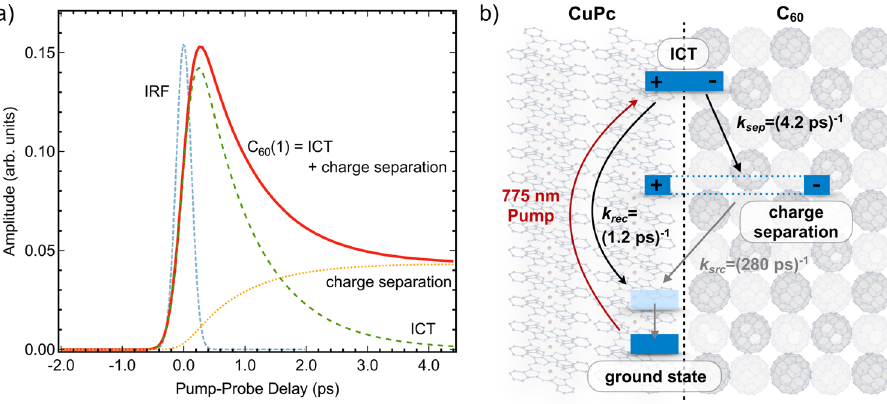
Fig. 5 Dynamic evolution of the C 60 (1) signal amplitude and kinetic modeling. a Temporal evolution and b kinetic modeling of the C 60 (1) peak intensity. The C 60 (1) peak intensity represents the fraction of C 60 signal that is shifted toward smaller binding energies due to increased electronic screening. The blue curve in a describes the instrument response function (IRF). The red C 60 (1) signal consists of a superposition of the fast-decaying ICT signal (green) and a contribution from separate electron – hole pairs (yellow) that are generated during the decay of the